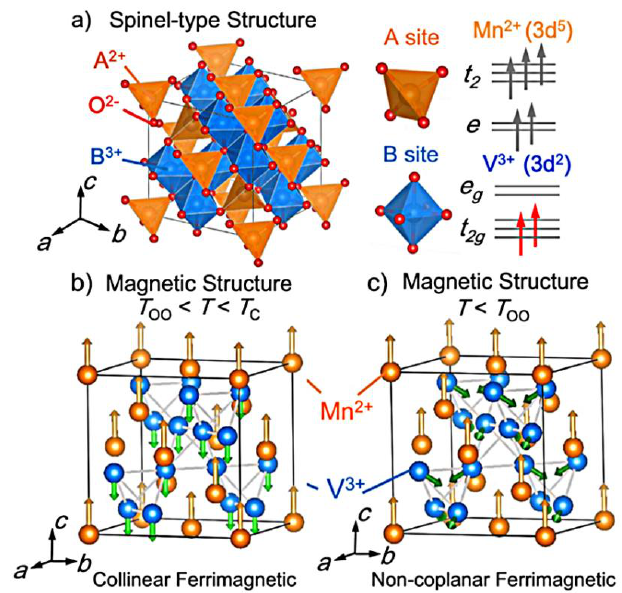
Figure 5. Effect by temperature variations on the phase crystal structure and magnetic structure organization. Panel ( a ) spinel-type oxide MnV 2 O 4 crystal structure A-site are surrounded by oxygen tetrahedron and B-site ions by octahedron. The V 3+ ion has orbital degeneracy in the t 2g orbital. Panel ( b ) The collinear ferrimagnetic structure. Panel ( c ) Magnetic structure in the non-coplanar ferrimagnetic tetragonal phase (c < a). Reprinted with permission from [48], published by Elsevier, 2018.